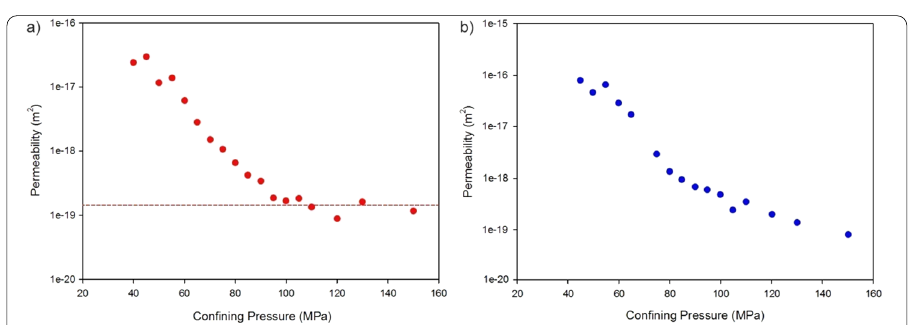
Fig. 10 Graphs of permeability against confining pressure through a single fracture (samples TTGW_11_3_5 ( a ) and TTGW_11_3_17 ( b )). Red dashed line indicates where permeability becomes stable. Overlapped graphs 10a and 10b are shown as Additional file 2: Figure S2, Additional file